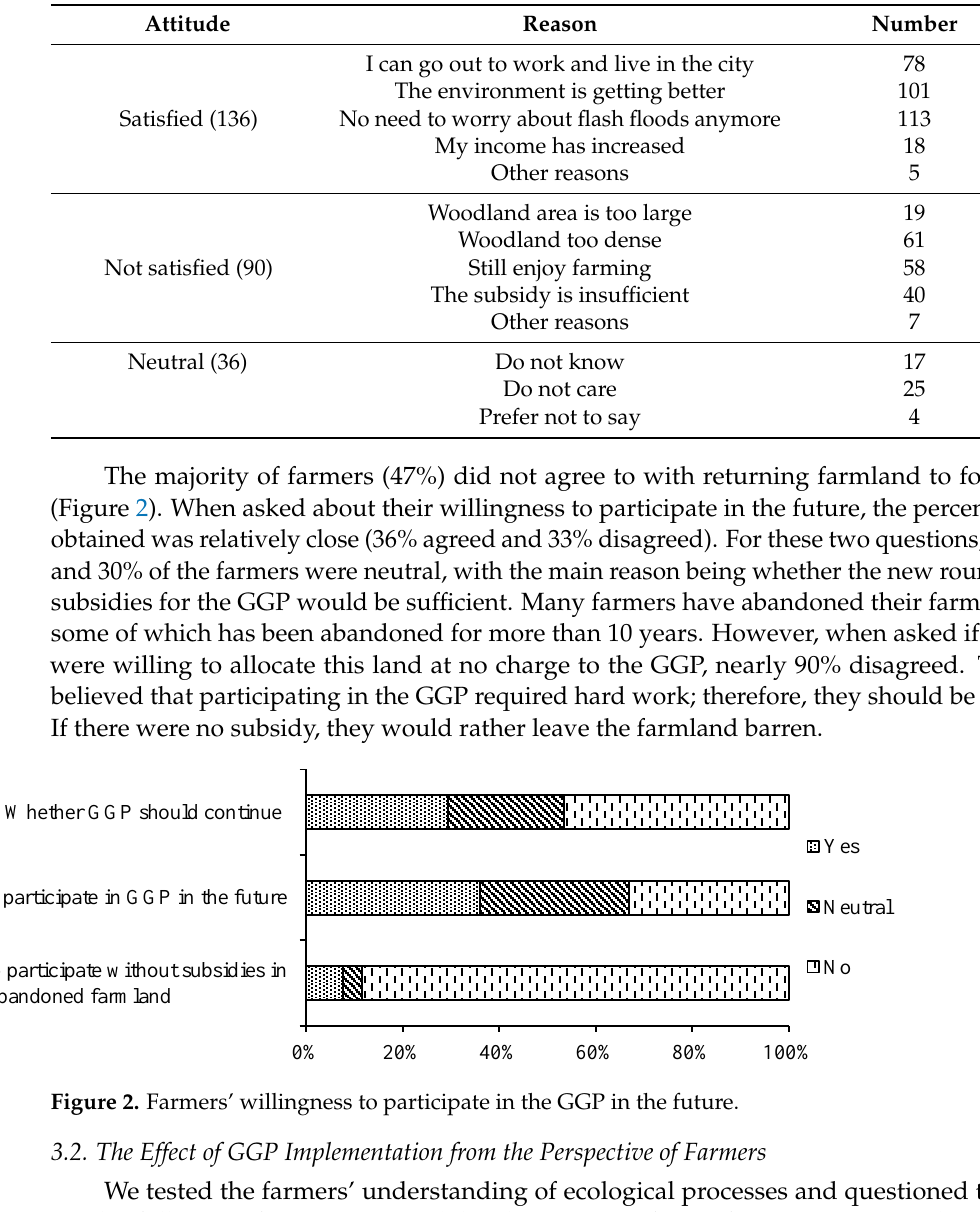
Table 2. Farmers’ satisfaction and reasons for the Grain for Green project.